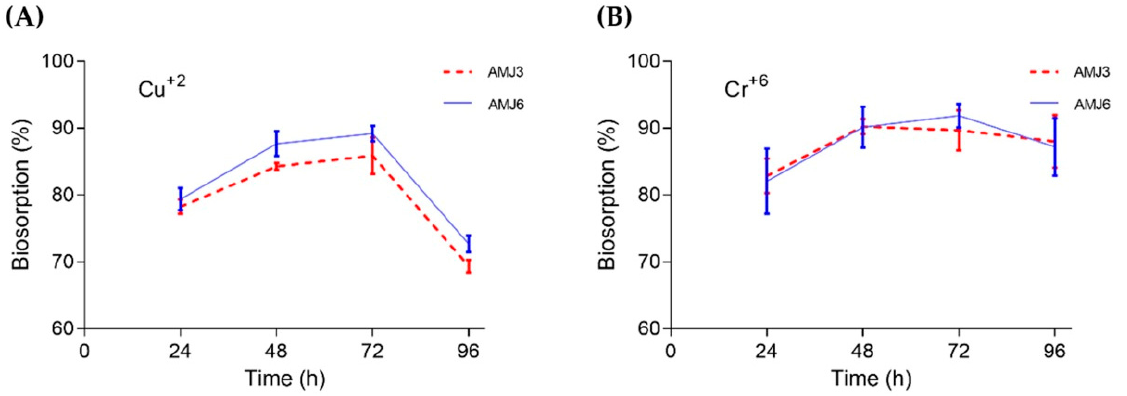
Figure 4. Biosorption of Cu +2 ( A ) ions in YPG broth (126 mM), and Cr +6 ( B ) ions (0.289 mM) in YPG broth using the Y. lipolytica AMJ3 and AMJ6 strains.